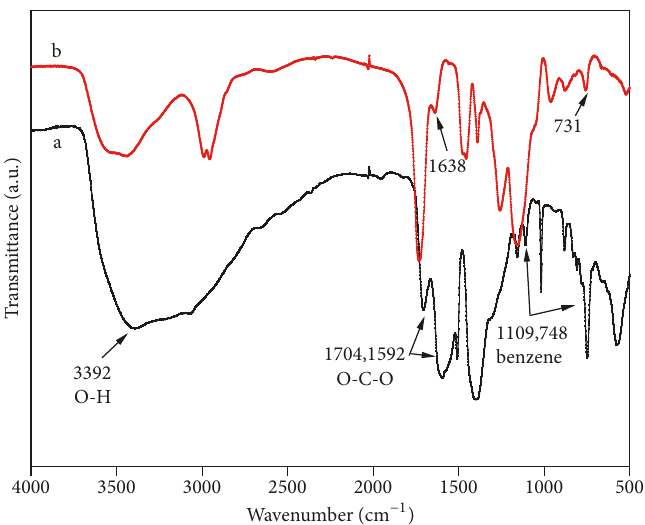
Figure 3: FT-IR spectrum of MIL-101 (a) and MIL@MIP (b).